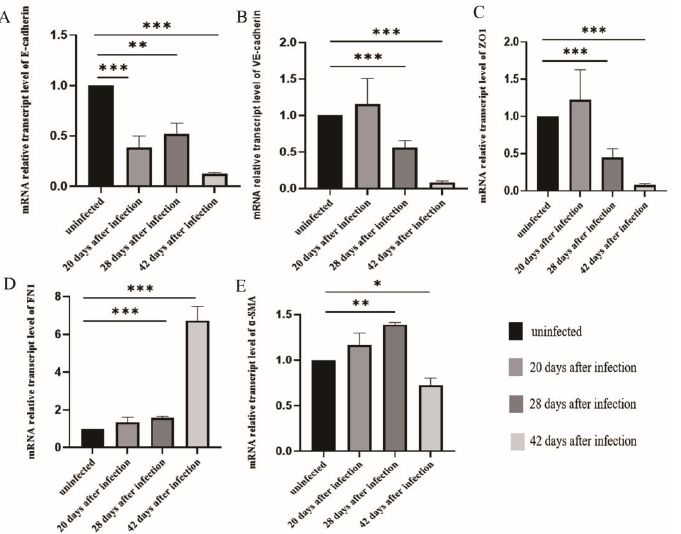
Figure 3. LSEC EMT after S. japonicum infection. ( A ) The level of E-cadherin mRNA expression in LSECs in mice post infection. ( B ) The level of VE-cadherin mRNA expression in LSECs in mice post infection. ( C ) ZO1 expression of LSECs in mice post infection. ( D ) FN1 expression in LSECs in mice post infection. ( E ) α -SMA expression in LSECs in the mice post infection. * p < 0.05; ** p < 0.01; *** p < 0.001.